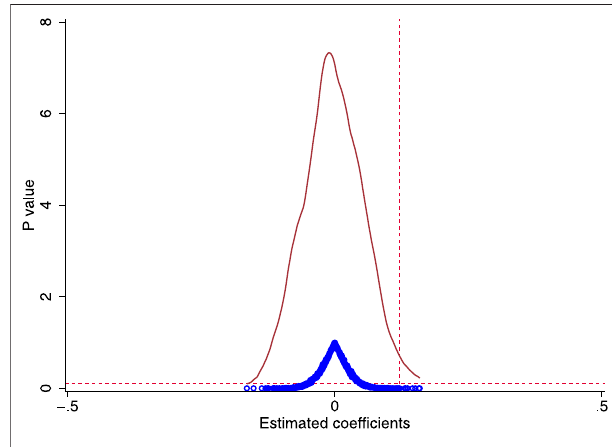
FIGURE 6 | Parallel trend test result of thermal power generation.